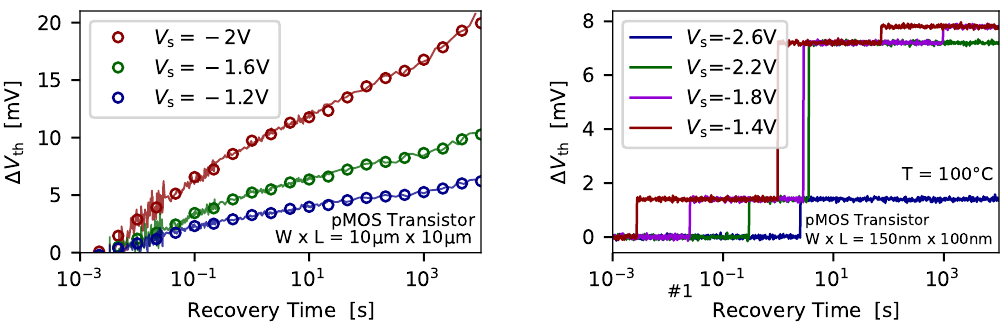
Figure 5. The temporal behavior of the drift of the threshold voltage is shown for pMOS transistors with two different geometries. ( left ) For large-area devices a continuous drift of the V th can be observed. As more defects become charged at higher stress biases the recorded ∆ V th increases too. ( right ) In nanoscale devices the number of single charge transitions, that is, the number of discrete steps in the ∆ V th , increase with higher stress bias. Also the average charge capture time move toward smaller values at higher stress biases.